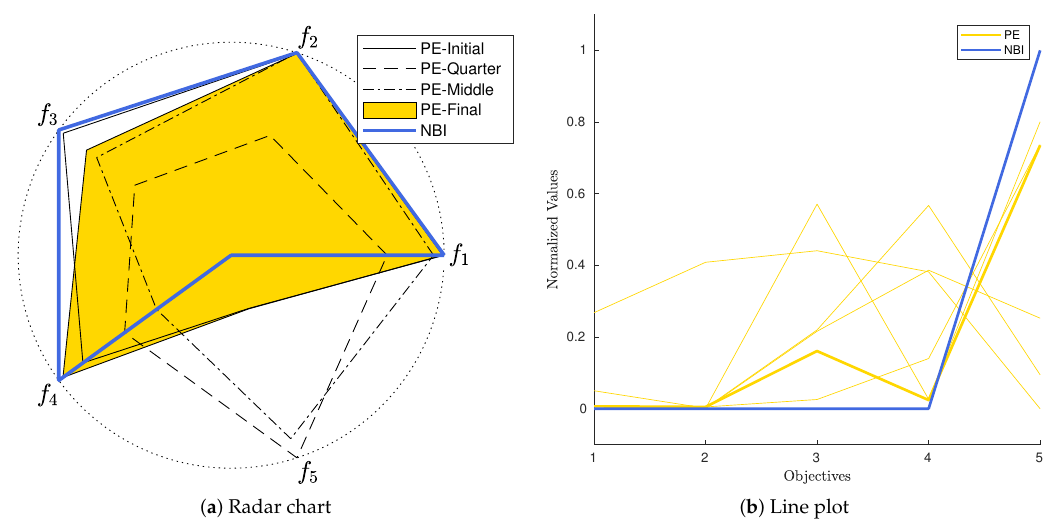
Figure 11. Numerical results for the second run of the C-convDTLZ2